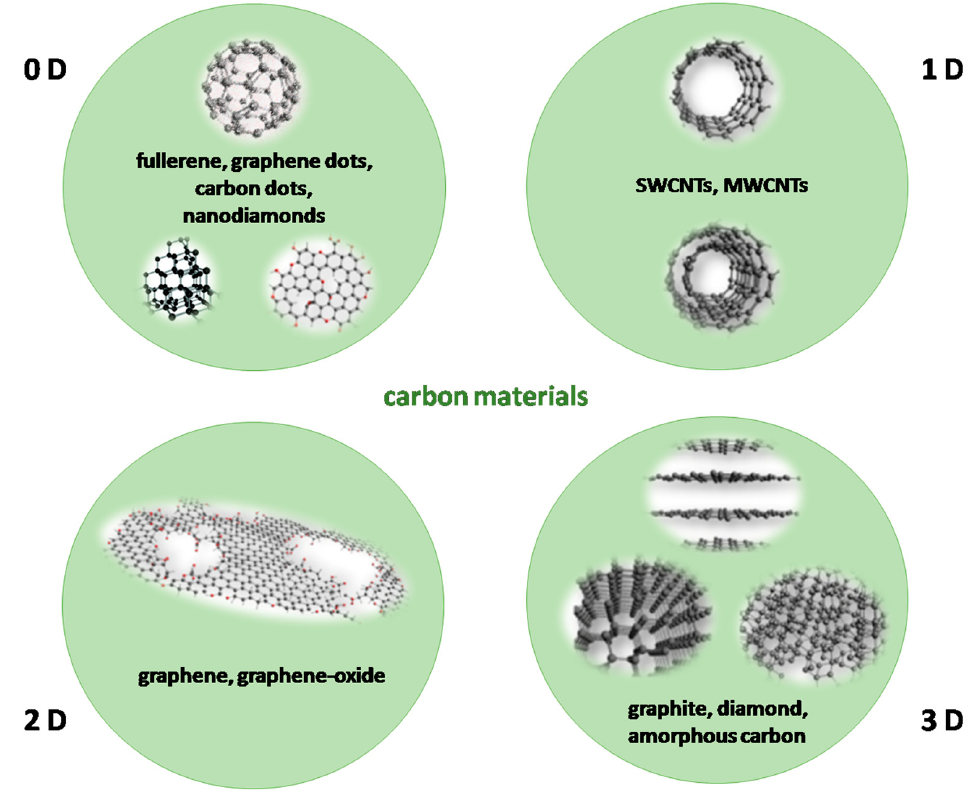
Figure 2. Classification of carbon materials according to their dimensionality.